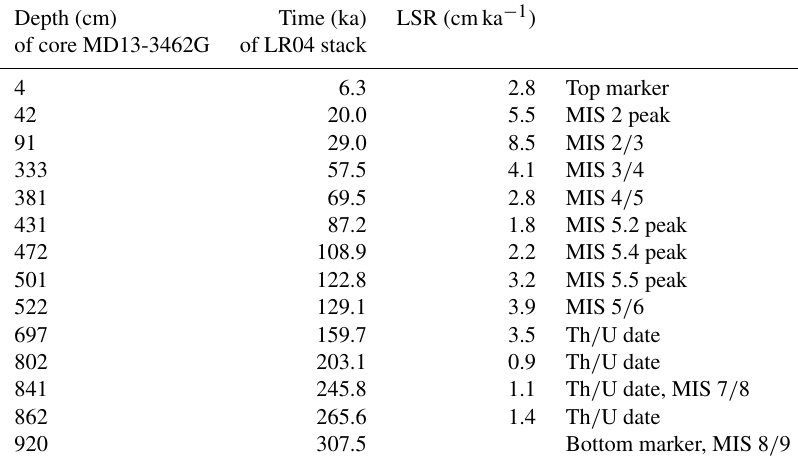
Table 3. Correlation pointers between sediment depth and time based on the benthic δ 18 O record of core MD13-3462G and the benthic LR04 stack of Lisiecki and Raymo (2005) for main Marine Isotope Stage (MIS) boundaries. The Pearson’s correlation coefficient ( r ) between the two records is 0.65 ( p< 0 . 001). Due to possibly unidentified hiatuses the linear sedimentation rate (LSR) should not be considered absolute but may serve as guidance to indicate changes in the sedimentary